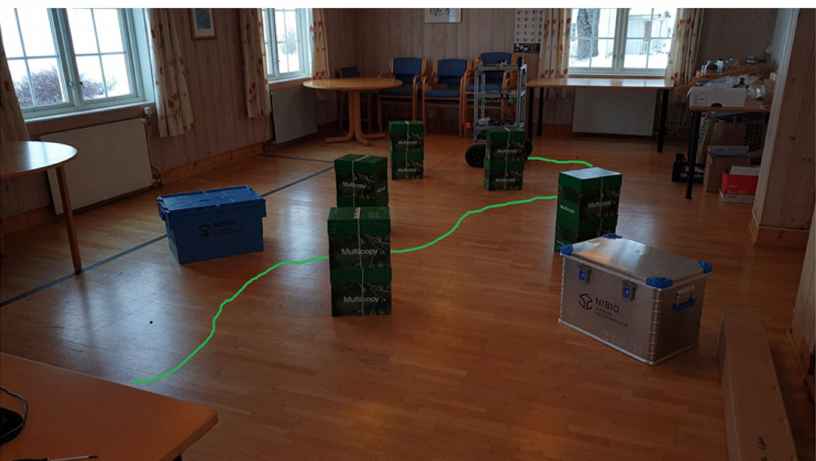
Figure 15. Experimental results showing static obstacle avoidance. The mobile robot traveled across the room past randomly placed boxes to a given waypoint. The virtual overlaid green line on the ground represents the path of the